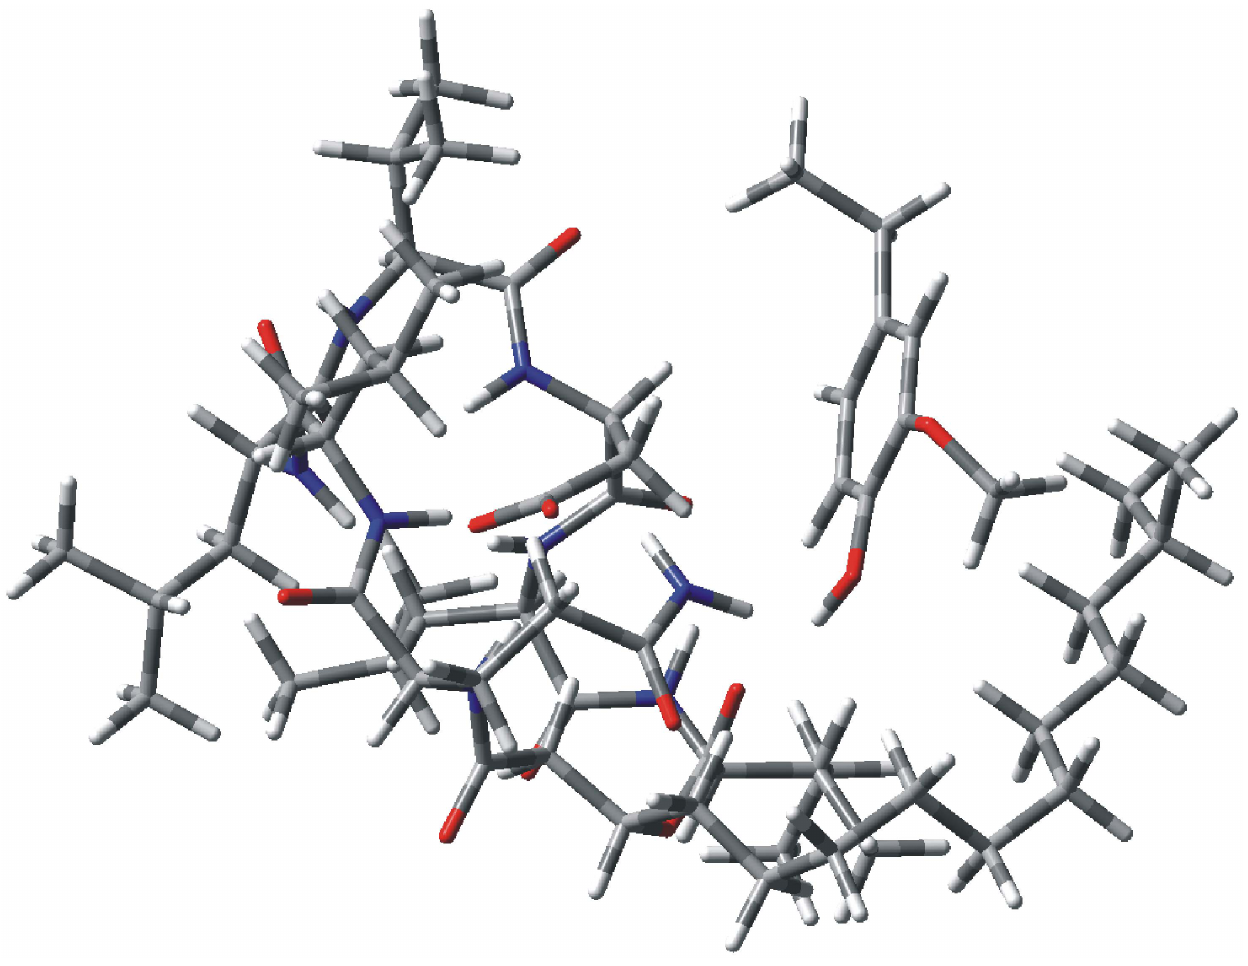
Figure 8. The dynamic conformation of lichenysins G and ligand.